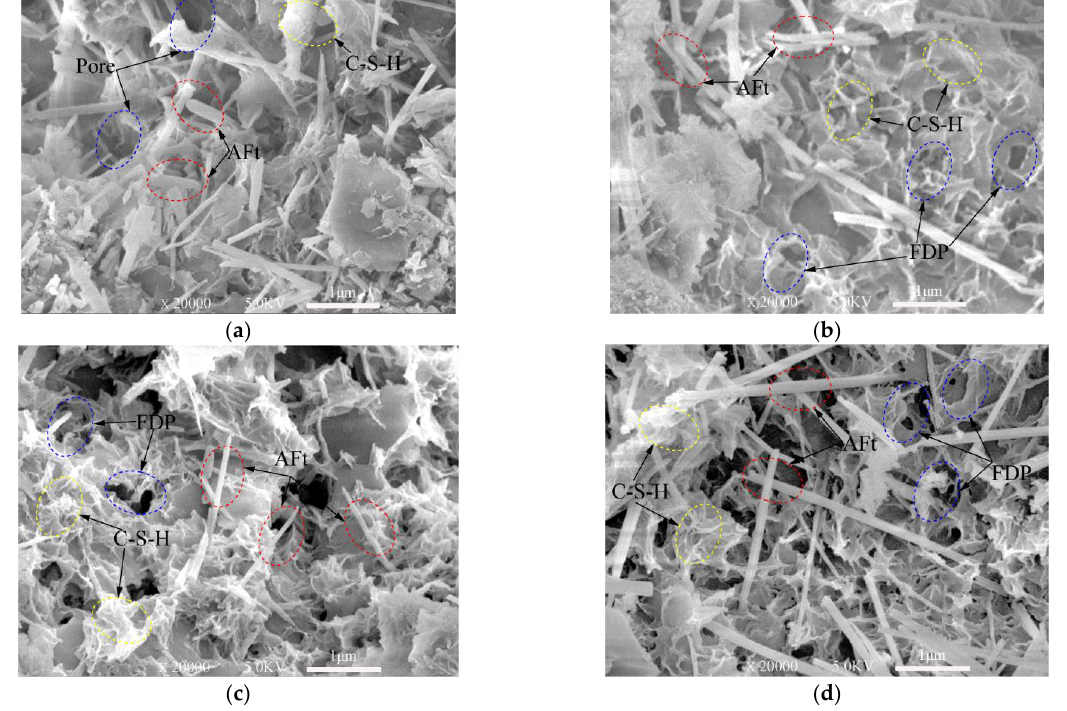
Figure 7. SEM images of 3-day samples under different freeze–thaw cycles. ( a ) Unfrozen; ( b ) After 5 freeze–thaw cycles; ( c ) After 10 freeze–thaw cycles; ( d ) After 20 freeze–thaw cycles.